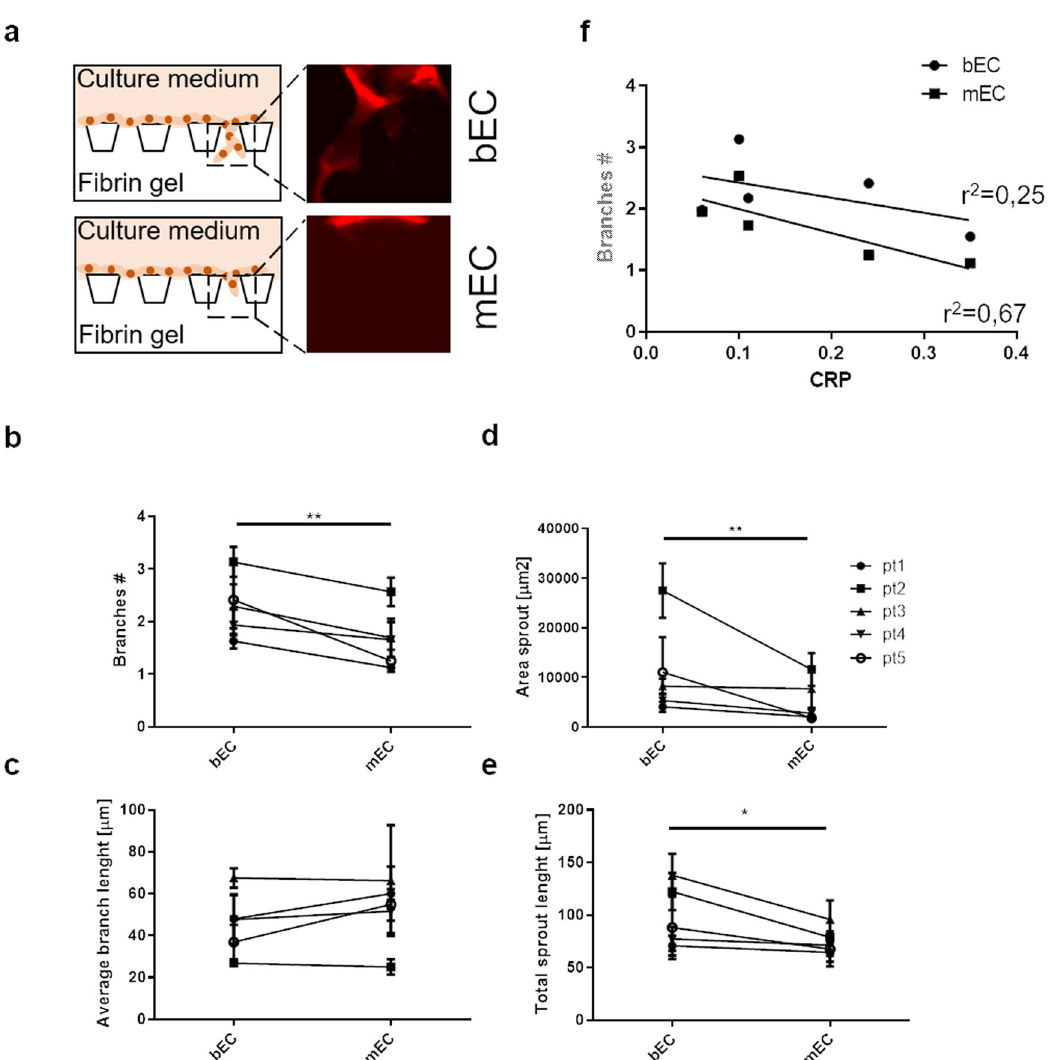
Fig. 3 Micro fl uidic sprouting assay to quantify angiogenic behavior of bECs and mECs in control conditions. a Schematics of the angiogenesis assay, showing the channel in which the ECs were seeded (upper part), separated by a row of posts from the lower channel containing fi brin. Images on the right show representative immuno fl uorescence images of bECs and mECs invading the fi brin channel. Paired comparison of b branch number, c average branch length, d area sprouting and e total sprout length between bECs and mECs of single patients ( n = 5, * p < 0.05; ** p < 0.01). Average and SEM of at least 5 replicates per patient are shown. f Interpolation of the branch number plotted against CRP values ( n = 5), showing a stronger negative linear correlation in mECs ( r 2 = 0.67, p = 0.08) as compared to bECs ( r 2 = 0.25, p = chip during the experimental time (Fig. 4a). Graphs in Fig. 4b – e in mECs, whose values remained signi fi cantly lower than bECs. report the values for angiogenic parameters normalized to the Total sprout length (Fig. 4e), increased both in bECs and in mECs value of bECs in control conditions. TNF α addition increased with TNF α addition. This higher length of the total sprouting was branch number (Fig. 4b) and area sprout (Fig. 4c) in bECs but not due to an increased value of the average length of each angiogenic